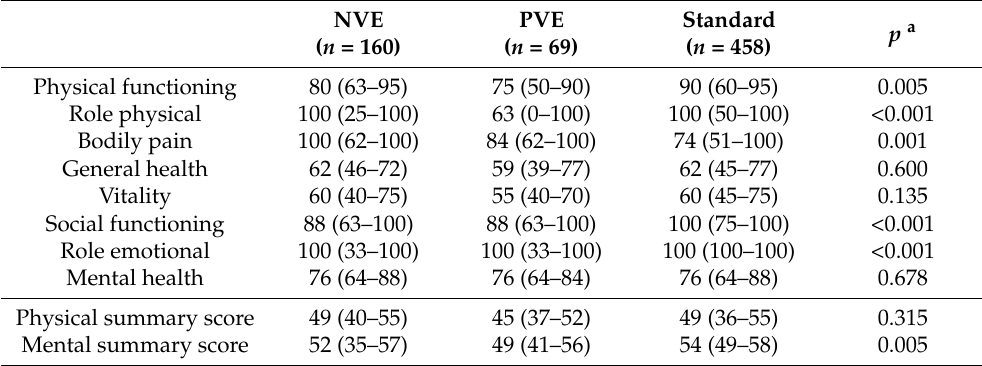
Table 3. Results of the SF-36 survey. NVE: native valve endocarditis and PVE: prosthetic valve endocarditis. Data are presented as medians (25–75th